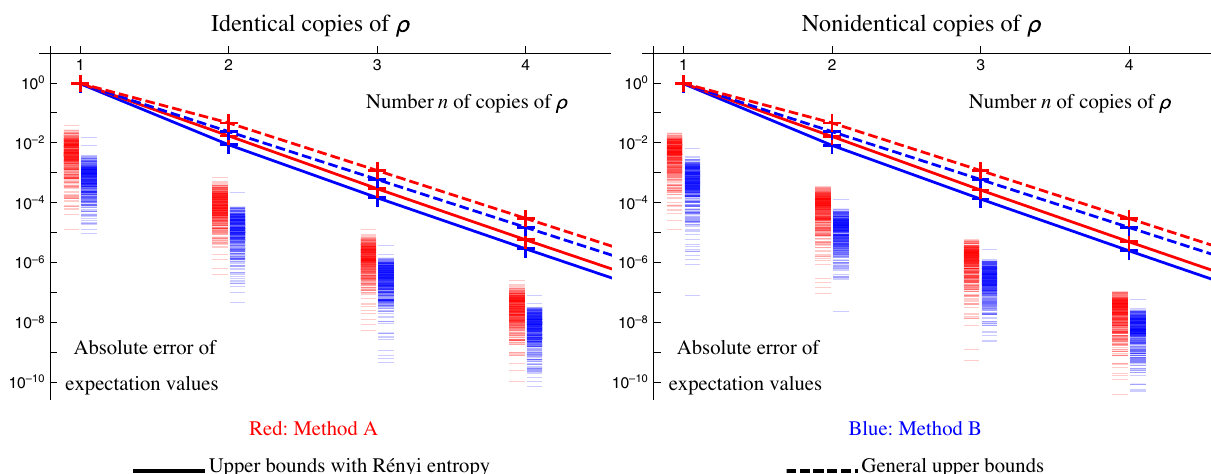
FIG. 2. Simulation of a 12-qubit state with 372 noisy quantum gates. Errors in estimating the expectation value in the dominant eigenvector h ψ j σ j ψ i decay exponentially with the number of copies n of the quantum state ρ . Dashed lines: our general upper bounds on the errors from result 1 and result 2 only require the knowledge of the dominant eigenvalue λ and the largest error probability p Eq. (1). Solid lines: our upper bounds based on the R´enyi entropy of the quantum states. Red and blue bars: approximation errors obtained with 500 randomly selected Pauli strings (observables σ ) are significantly below the upper bounds. (left) All copies of ρ are perfectly identical and (right) all copies of ρ are significantly different (but they commute as this case can be simulated efficiently) and their trace distance is 0.01 due to their different eigenvalue